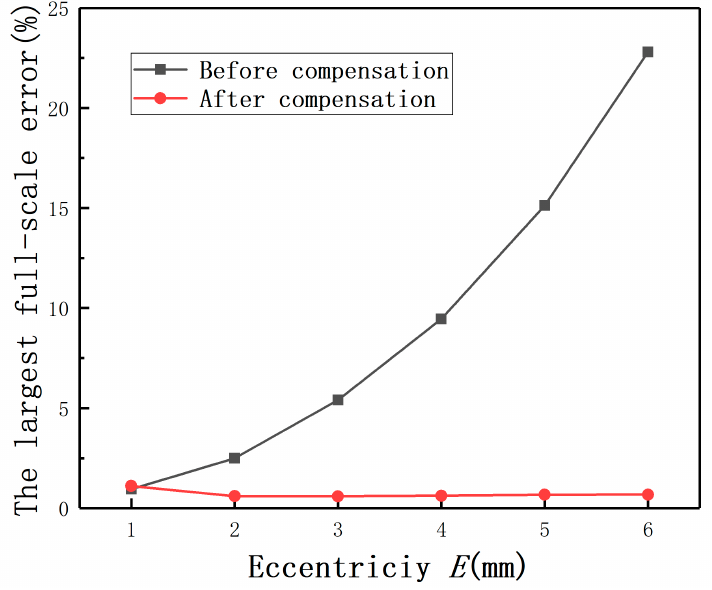
Figure 28. The largest full-scale errors before and after compensation.